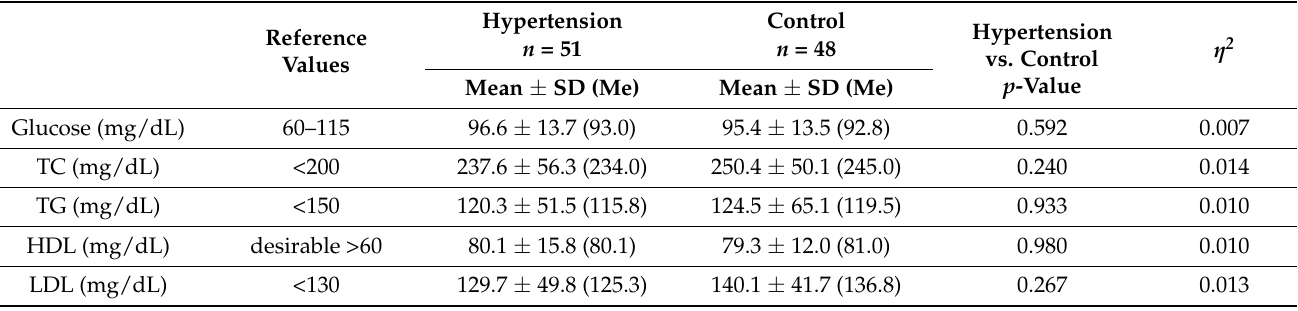
Table 5. Biochemical variables (mean ±